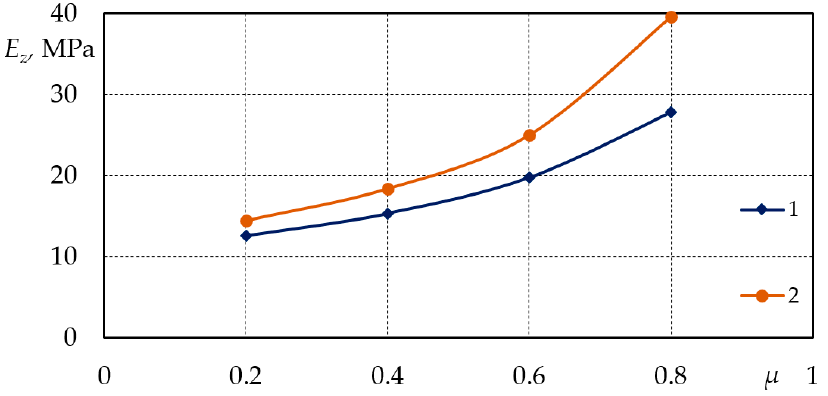
Figure 14. Dependence of tire band deformation on the coefficient of friction ( σ z = 0.2 MPa, E r = 6 MPa) using different breaker models: 1—7 layers and 2—8 layers.